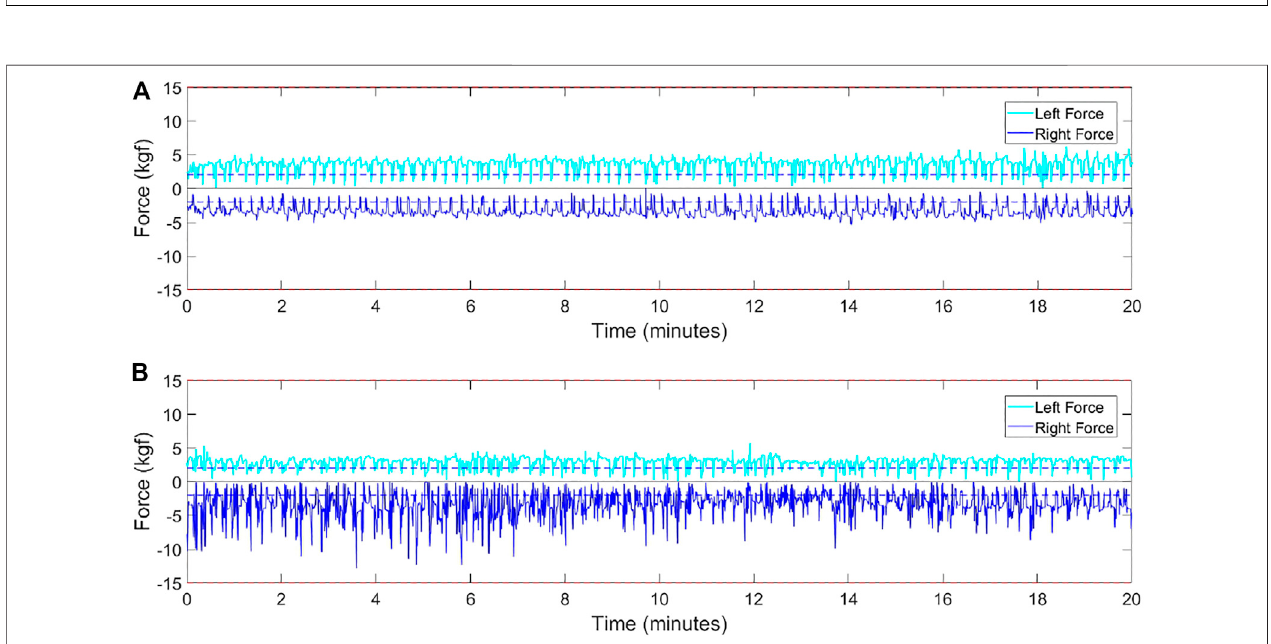
FIGURE 9 | Force pro fi les: (A) healthy subject, (B) left hemiparetic subject.